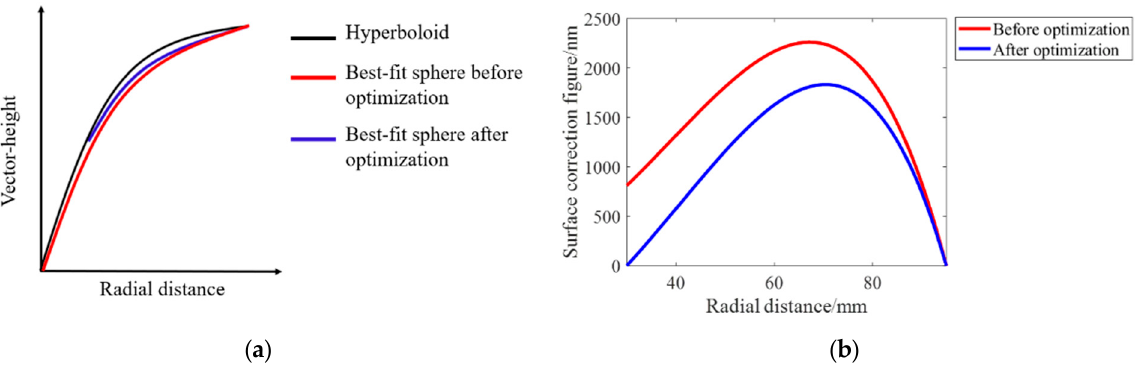
Figure 2. Effectiveness of the optimization fitting method. ( a ) best-fit sphere; ( b ) surface correction figure.